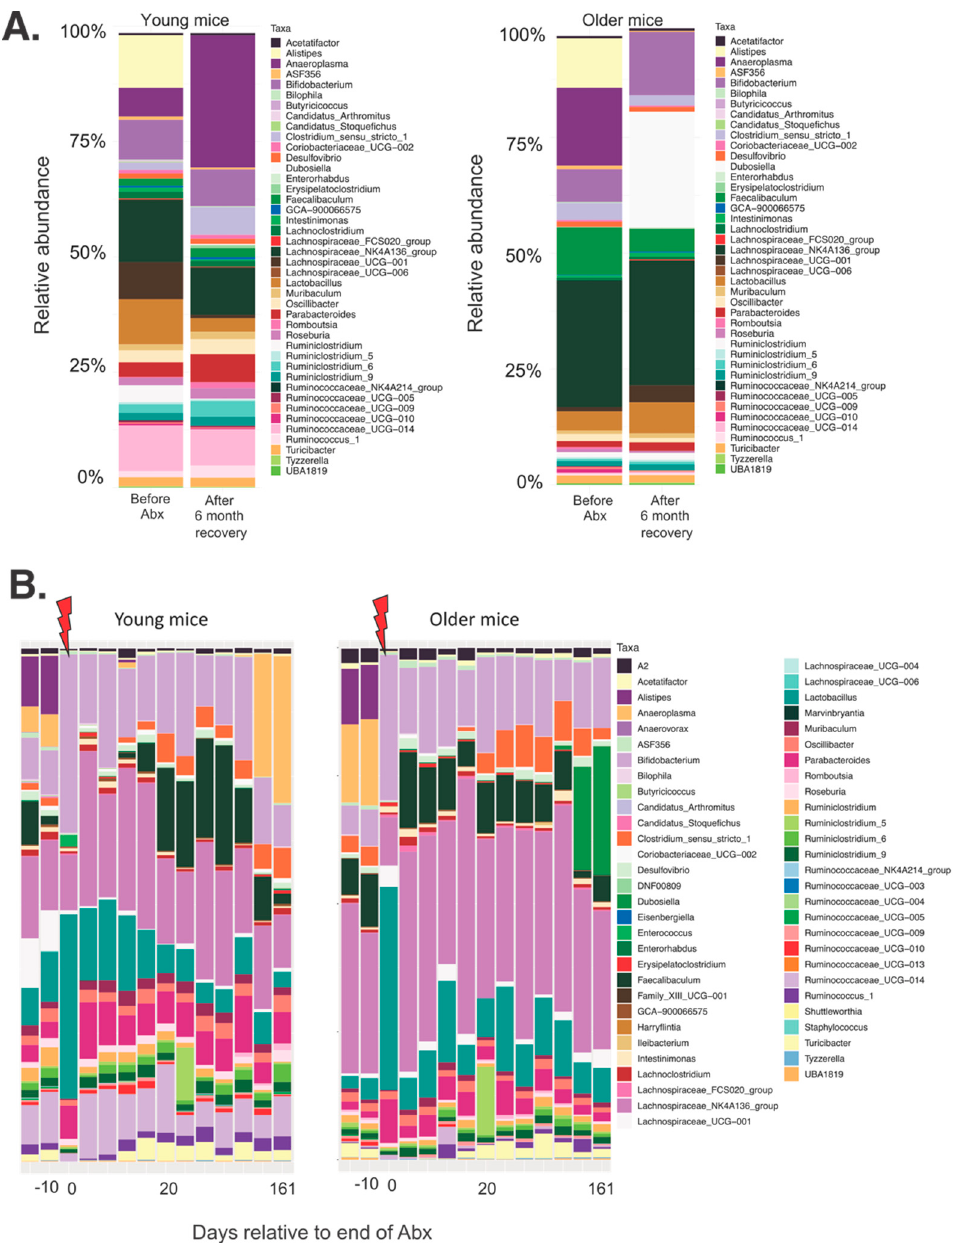
Figure 4. Changes in the distribution of abundant genera in fecal samples from young and older mice ( A ) before Abx and 6 months after the Abx treatment, and ( B ) all of the collections timepoints. Genera with relative abundance lower than 0.5% were removed from the graphs for clarity.